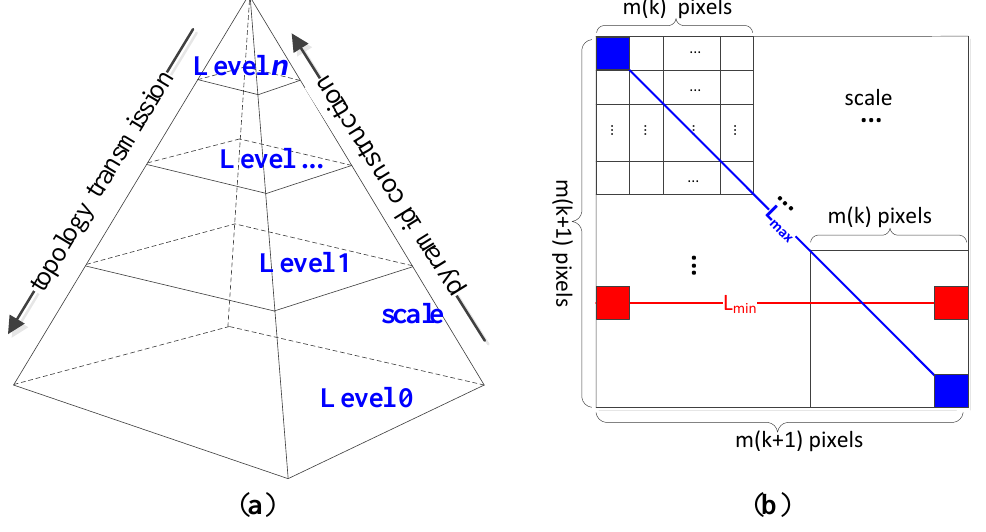
Figure 3. The structure of the image pyramid and the illustration of image resolutions. ( a ) The image pyramid from level 0 (original water mask) to level n, with scale factor s between each level. ( b ) The image spatial resolution change from level k to level k +1 in the image pyramid, and minimum and maximum distances that neighbours will be connected at level k